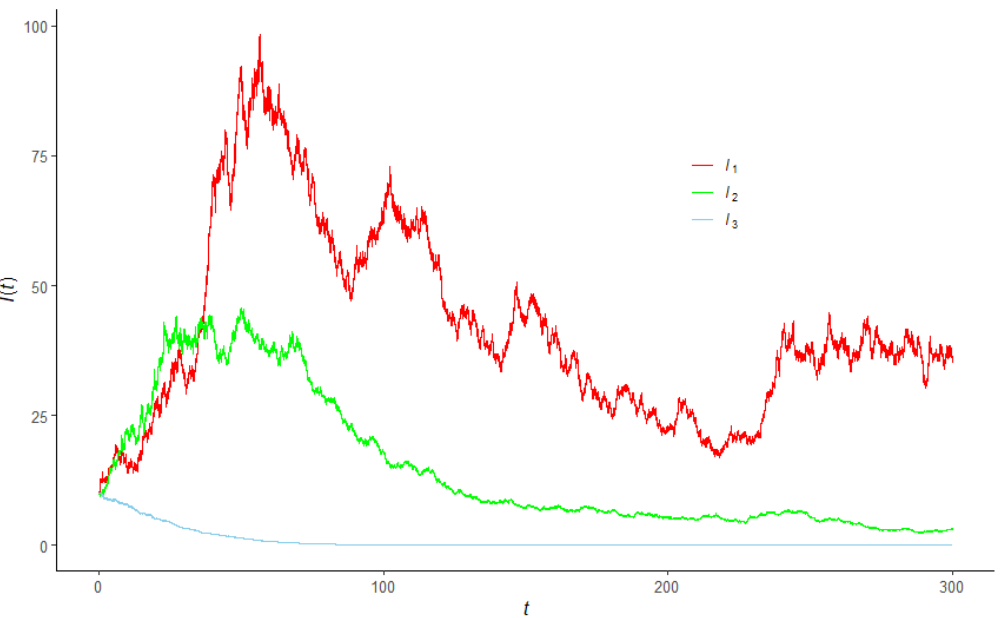
Figure 6. The simulated numbers of total infected individuals under the different (𝑞 0 ,𝑞 1 ) combina- tions.